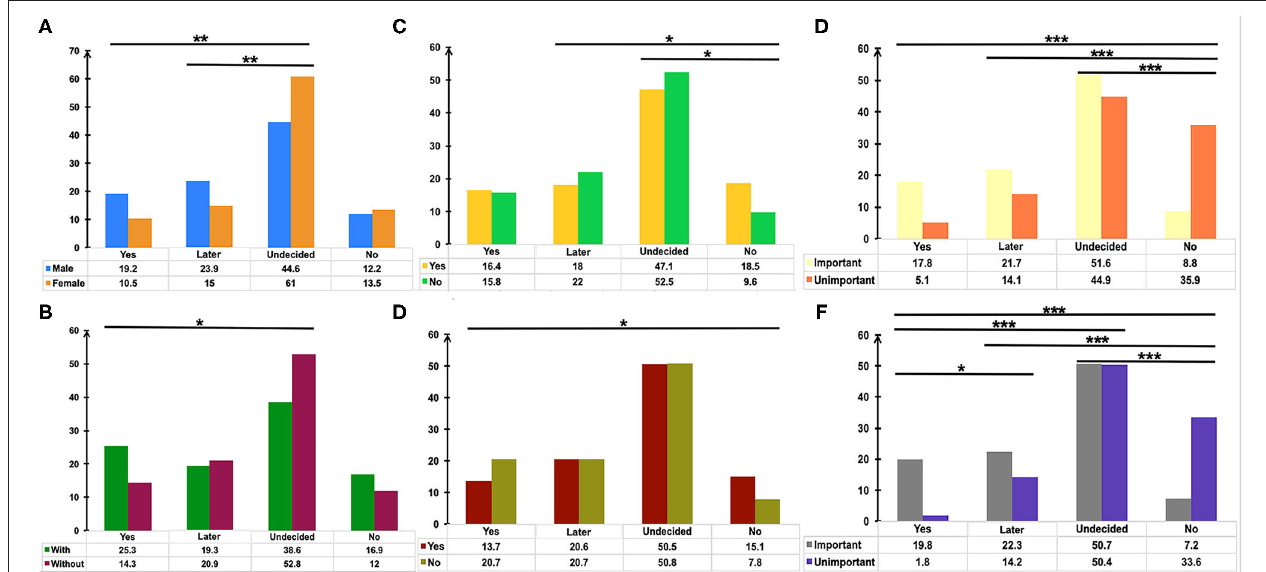
FIGURE 2 | The potential factors influencing the attitudes of patients with IBD toward COVID-19 vaccination. Pairwise comparison of Chi-square test was used to determine the differences of gender (A) , medical or biomedical background (B) , immunosuppressants usage (C) , immunocompromised status (D) , the importance of vaccination for the health of others (E) , the importance of vaccination for self-health (F) between groups. P values were adjusted according to the Bonferroni method. * p < 0.0083, ** p < 0.0017, *** p < 0.00017.